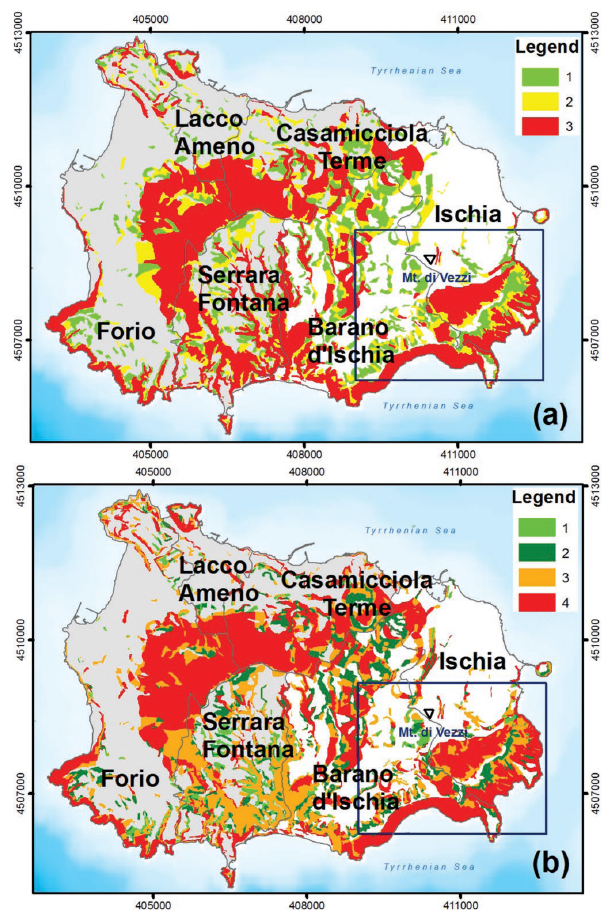
Fig. 17. Relative hazard (a) and risk (b) maps of the Ischia island (after BANCR, 2010, modified). Hazard map legend: (1) low rel- ative hazard; (2) medium relative hazard; (3) high relative hazard. Risk map legend: (1) moderate risk; (2) medium risk; (3) high risk; (4) very high